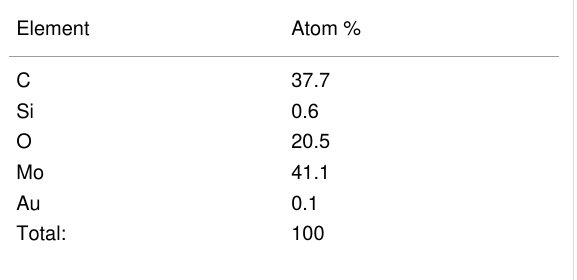
Table 3: Elemental composition of Mo(CO) 6 FEBID deposits obtained by EDX measurement of a 1 μ m 2 pad deposited on a 100 nm thick polycrystalline gold substrate on a 4 inch silicon